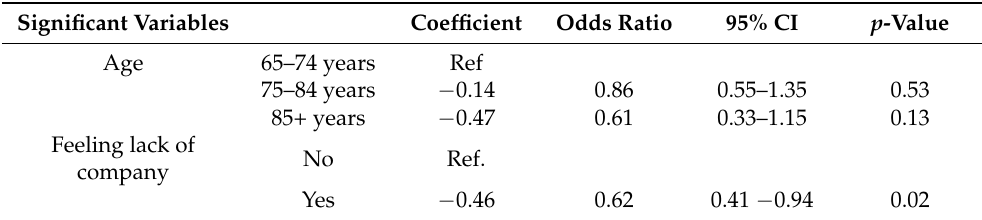
Table 5. Logistic regression with digital social participation (Low = 0, High = 1) as a dependent (Y) and age and lack of company as independent